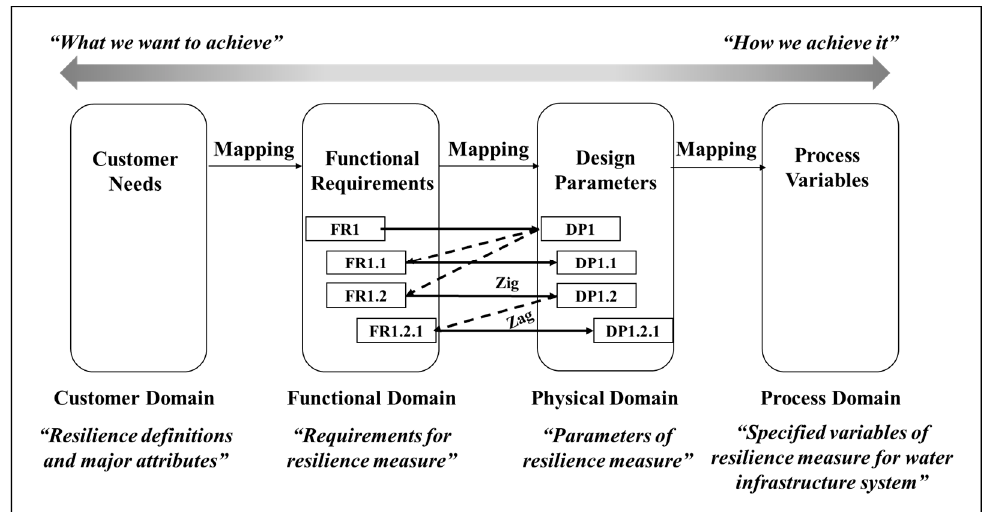
Figure 1. Axiomatic Design process with four domains (Modified from [48]).